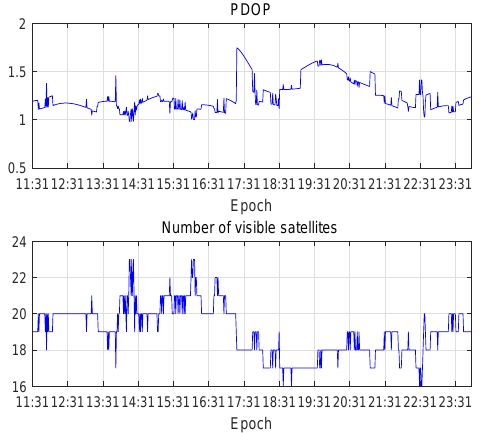
Figure 7. The PDOP and the number of visible satellite during the experimental period.